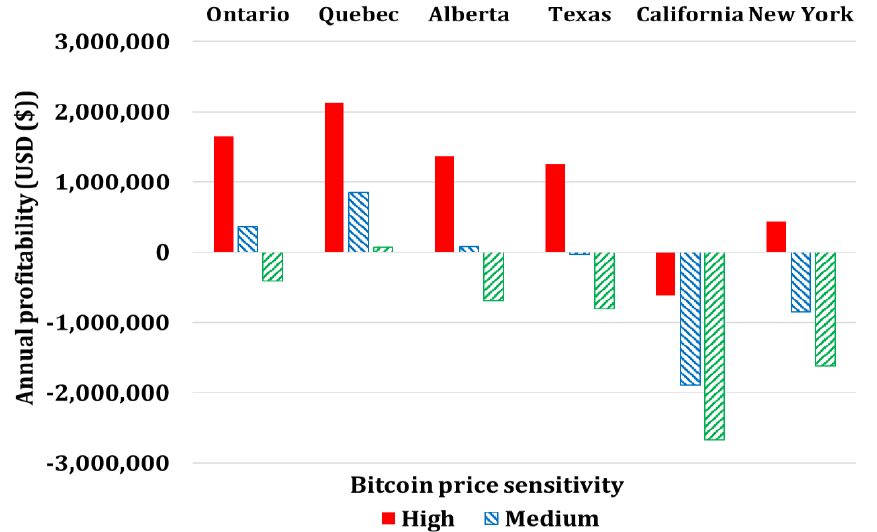
Figure 23. Annual profitability results of operating a commercial MightyPOD container in six North American locations measured in USD.